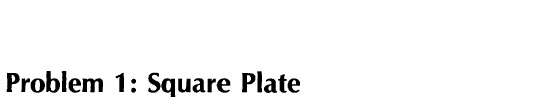
Table 4. 50 x 50 Square